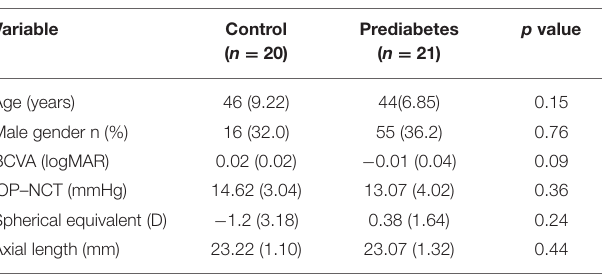
TABLE 1 | Baseline